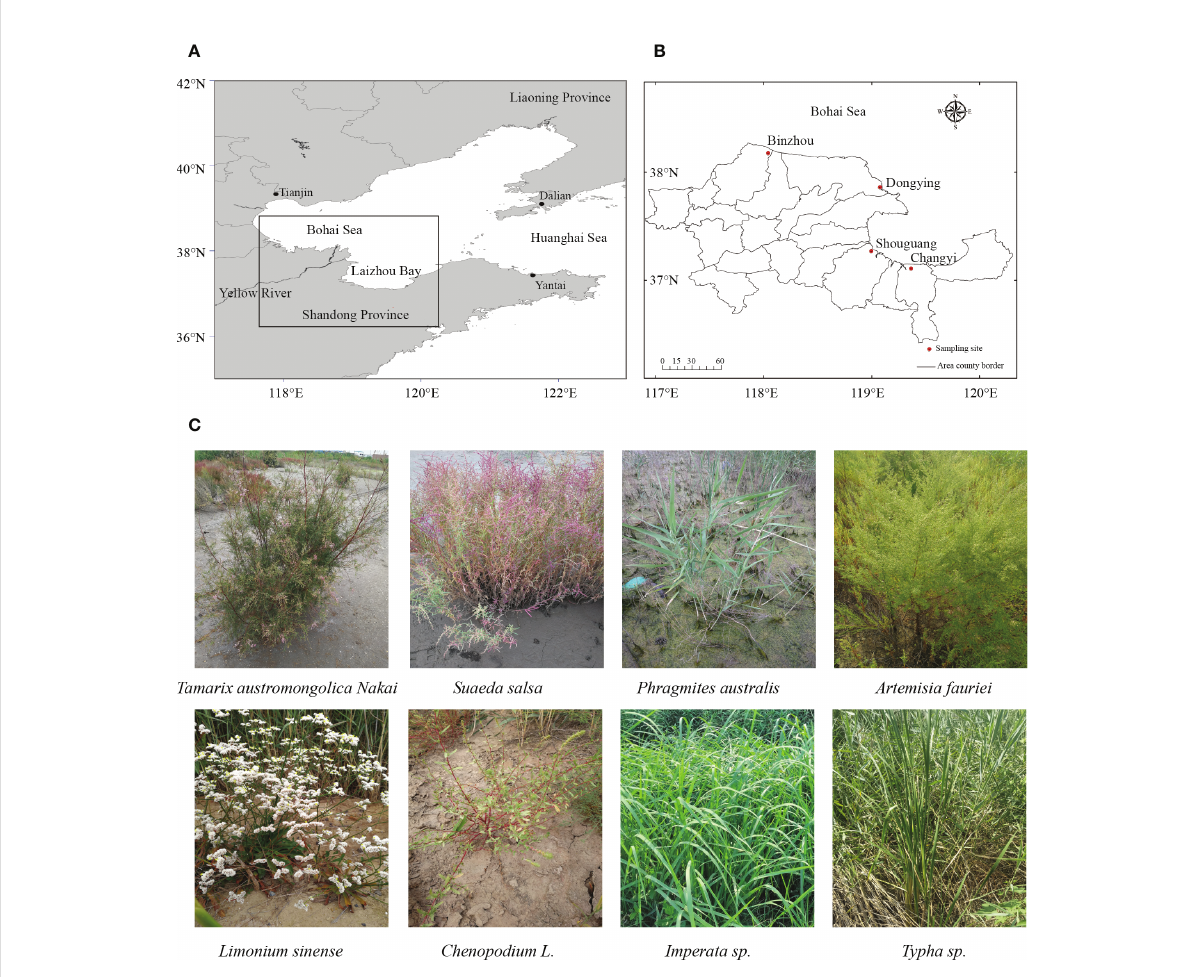
FIGURE 1 Images showing the locations and plants of sampling sites. (A, B) Geographic maps showing the sampling positions at the south coastal plain of the Laizhou Bay and the mouth of the Yellow River in China. (C) Phenotypes of representative plants for ryhizospheric soil